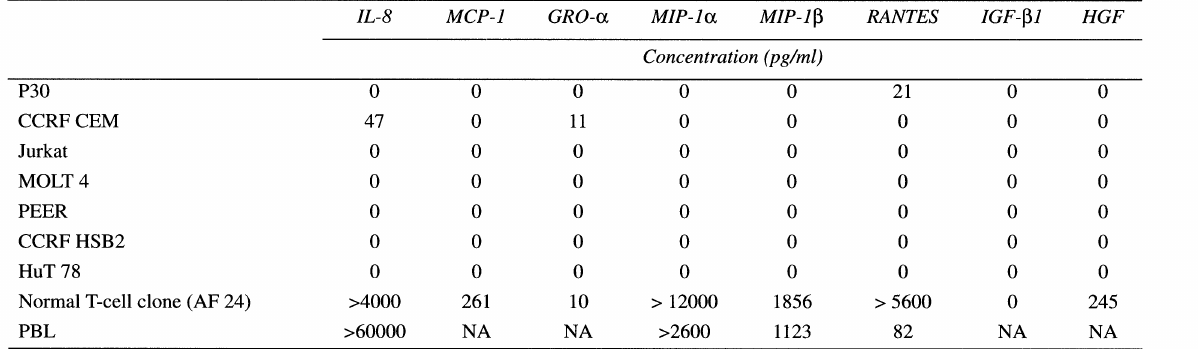
TABLE The concentration of chemokines and cytokines in conditioned media from different T-leukemia cell